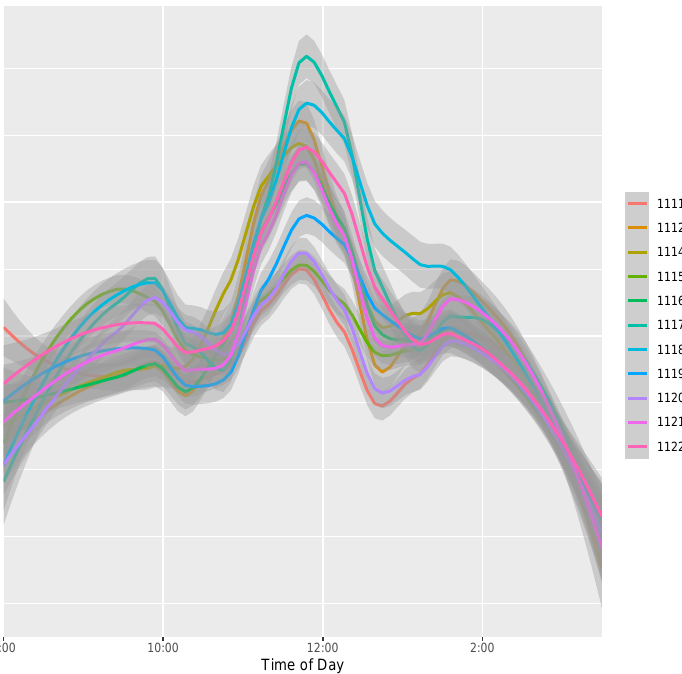
Figure 5. First column of weekly activity for 11 subjects over five days.